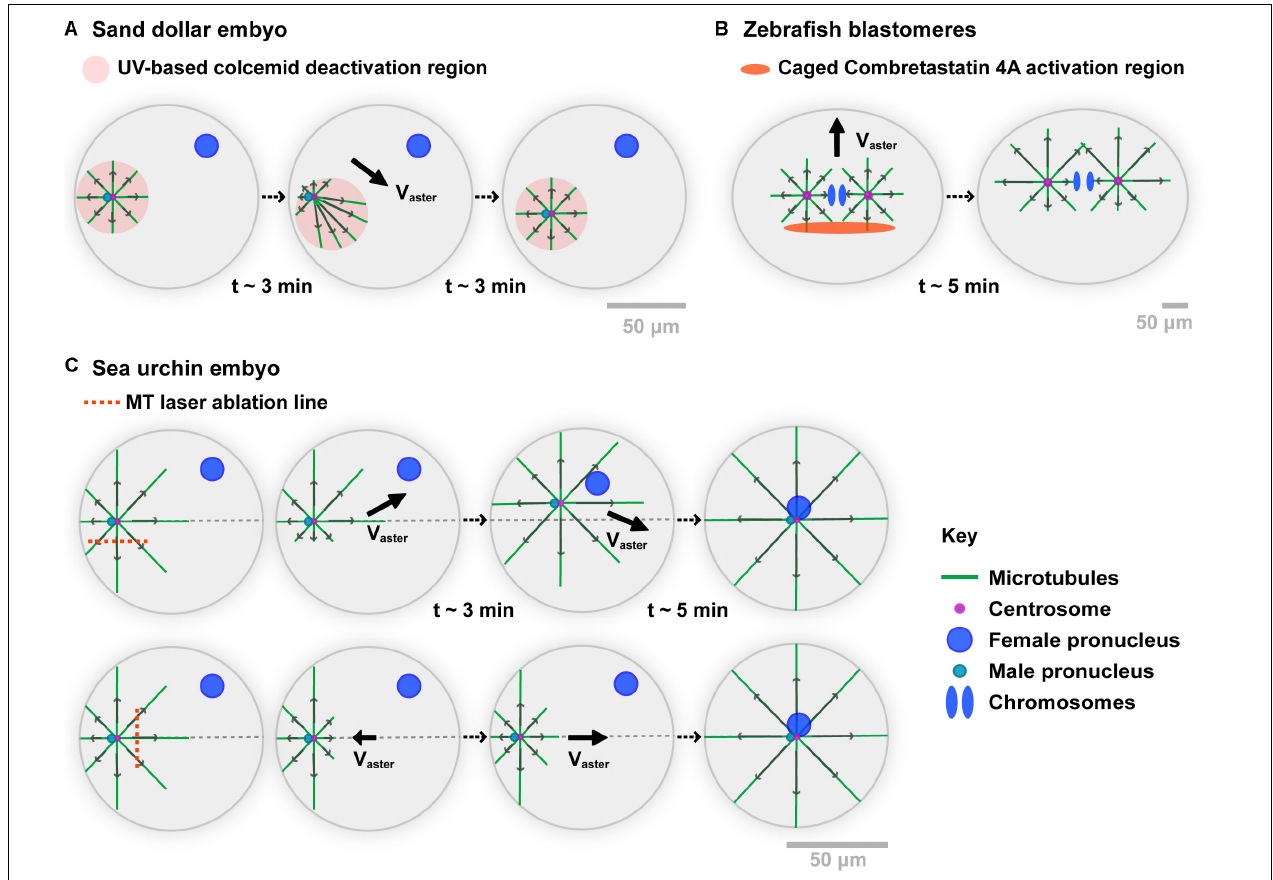
FIGURE 1 | Experimental evidences of the role of MT cytoplasmic pulling forces for aster motion. (A) A Sand dollar embryo is fertilized in the presence of the MT drug Colcemid. Using UV light, MTs are allowed to polymerize in specific regions. When moving the UV region, the sperm aster migrates to the center of the new region, following the direction of longer MTs. As MTs do not contact any cortex, those experiments support that forces exerted by MTs in bulk cytoplasm can drive aster motion and positioning. Modified from Hamaguchi and Hiramoto (1986). (B) Zebrafish 2-cell stage blastomeres are incubated in caged combretastatin 4A. Local UV-based uncaging allows for locally depolymerizing MTs in asters. Asters move following their longer MTs, long before those contact the cortex, supporting MT cytoplasmic force exertion. Modified from Wuhr et al. (2010). (C) Sea urchin embryos are fertilized, and MT centering asters are cut with a UV-laser along the indicated lines while they move to the cell center. Laser ablation on the side of asters causes a transient deviation toward the top of the cell, supporting MT bulk pulling. MT regrowth promote a return of the aster to the centration path. Similarly, laser cuts at aster front cause aster to transiently step back, and move again to the cell center upon MT regrowth. Modified from Tanimoto et al.